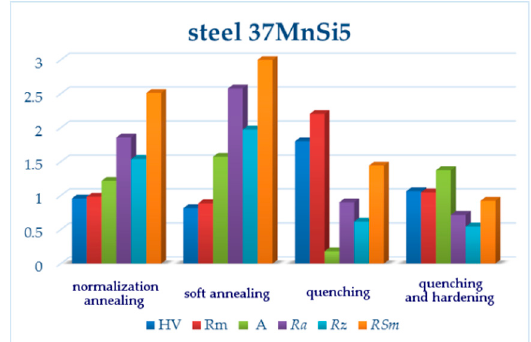
Figure 14. Relative changes of mechanical characteristics and measured surface roughness parameters for 37MnSi5. All values were normalized, being divided by respective reference values (170 HV, 880 MPa, 19%; Ra , Rz, RSm values for the upper line of the normalization annealing sample).